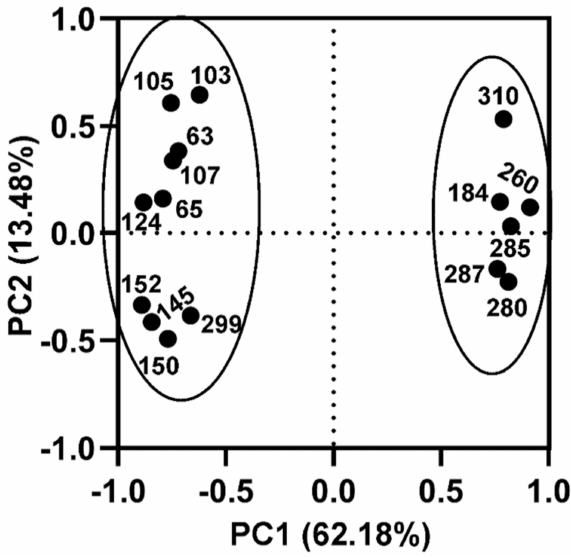
Figure 2. Principal component analysis on spot volume data with statistically significant ( p < 0.05) intensity difference between the low − and high − plasma-PACAP (pituitary adenylate cyclase-activating polypeptide) − level cows. The two principal components (PC1 and PC2) explain- ing the majority of the variation in the dataset are plotted against each other. This plot explains 62.18% + 13.48% = 75.65% of the variation in the data. Ten spots showed a higher intensity in the high-PACAP-concentration group compared to six spots in the low-PACAP-concentration group (Figure 3). The 16 spots with statistically significant intensities between groups were cut out from the gels. The proteins present in the spots were identified using the LC-MS/MS method (Table 1) and classified as immune- related proteins, lipid-metabolism-related proteins and transport